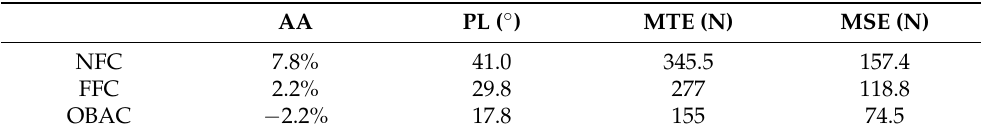
Table 2. Performance indexes at static loading